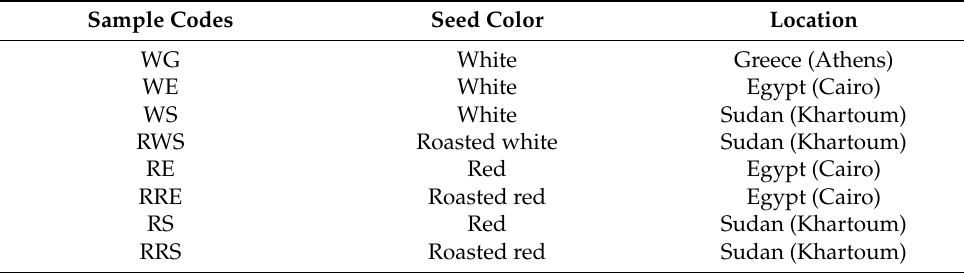
Table 1. Origins of the different P. mahaleb seed accessions used in